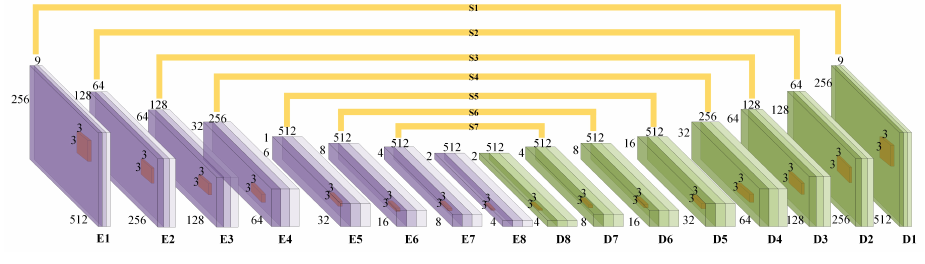
Figure 5. Generative